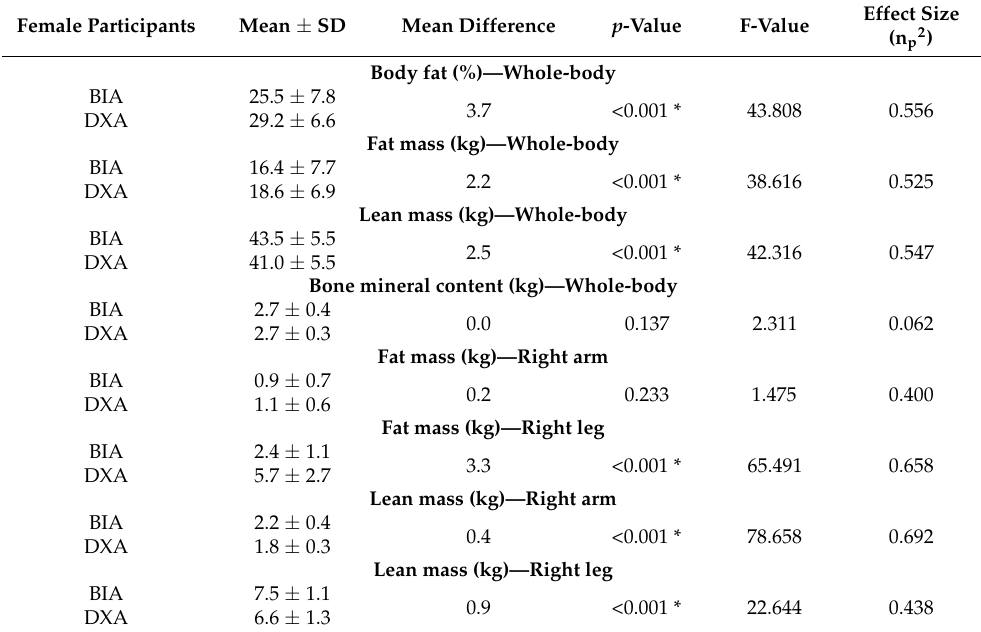
Table 3. Descriptive statistics (mean ± standard deviation) and one-way repeated measures ANOVA test results comparing BIA and DXA for body fat percentage, fat mass, lean mass and bone mineral content at the whole-body and/or segmental level on the right-hand side of the body for women ( n =